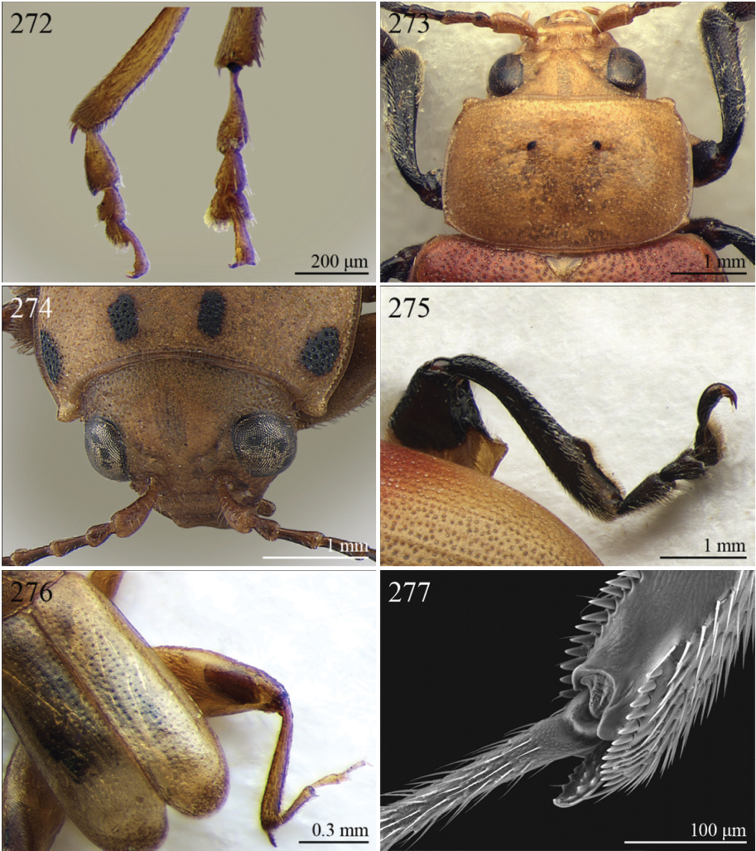
Morphological characters. 272
Upembaltica scolytina Bechyné, metatarsus in lateral (left) and dorsal (right) view 273
Xanthophysca perrieri Fairmaire, head and pronotum in dorsal view 274 Ditto, head in subfrontal view 275 Ditto, hind leg and elytral punctation 276
Yemenaltica scorteccii Scherer, hind leg and elytral punctation 277
Yemenaltica furthi Döberl, serrate apical spur of hind tibiae.